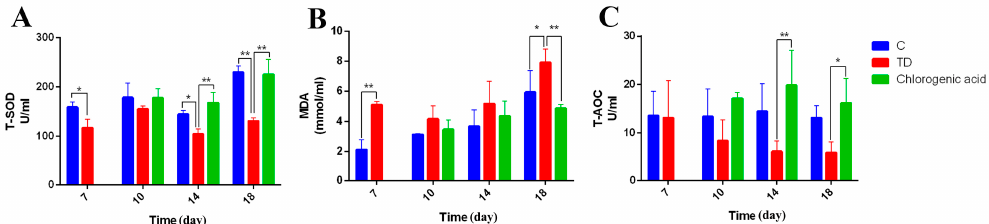
Figure 4. Chlorogenic acid improves antioxidant level of chickens. ( A – C ) Antioxidant activities analysis of serum samples in Control, TD and CGA groups on days 7, 10, 14 and 18. T-SOD represents the vitality of total superoxide dismutase, MDA represents the concentration of malonic dialdehyde, and T-AOC represents the total antioxidant capacity. The data are expressed as means ±SD. * p < 0.05, ** p < 0.01.